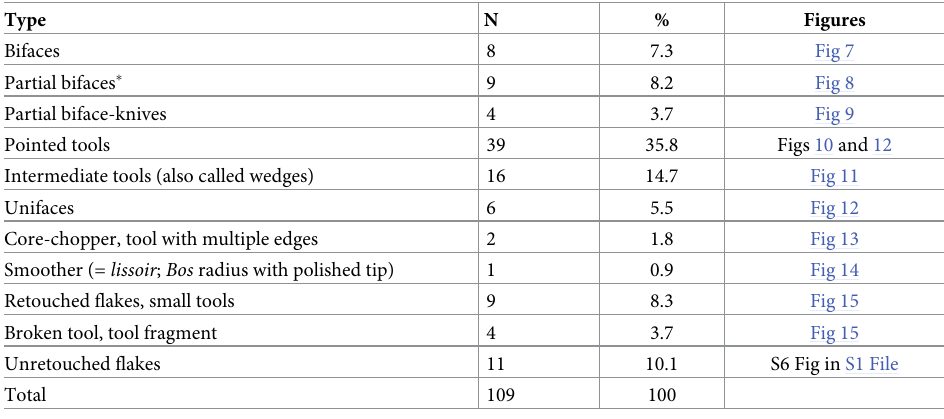
Table 4. Castel di Guido bone tool specimens with index of confidence 2 or 3.